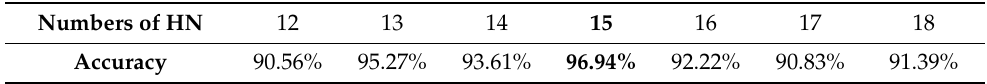
Table 6. Accuracy on testing data in scheme